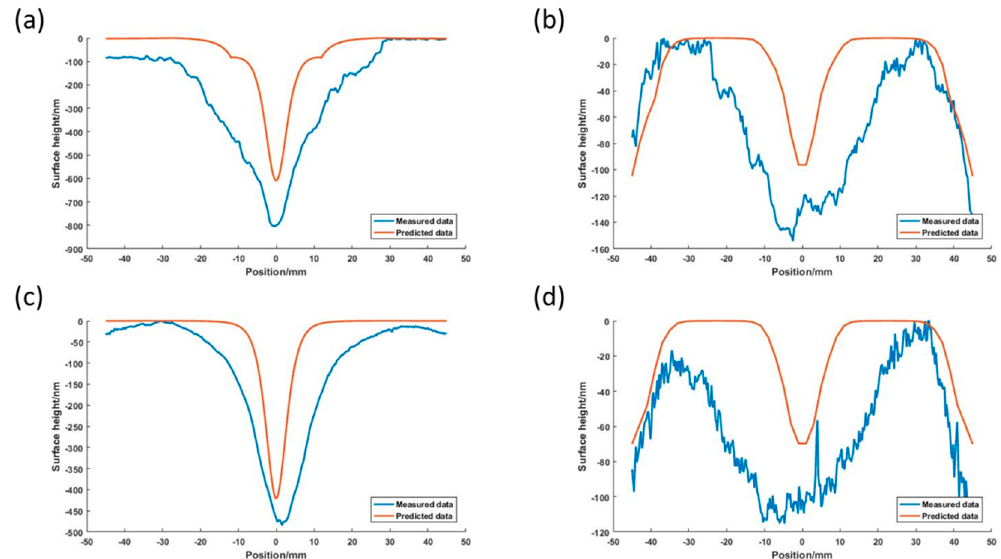
Figure 8. Comparison of predicted and experimental results: ( a ) is Trial No.1; ( b ) is Trial No.2; ( c ) is Trial No.3; and ( d ) is Trial No.4.